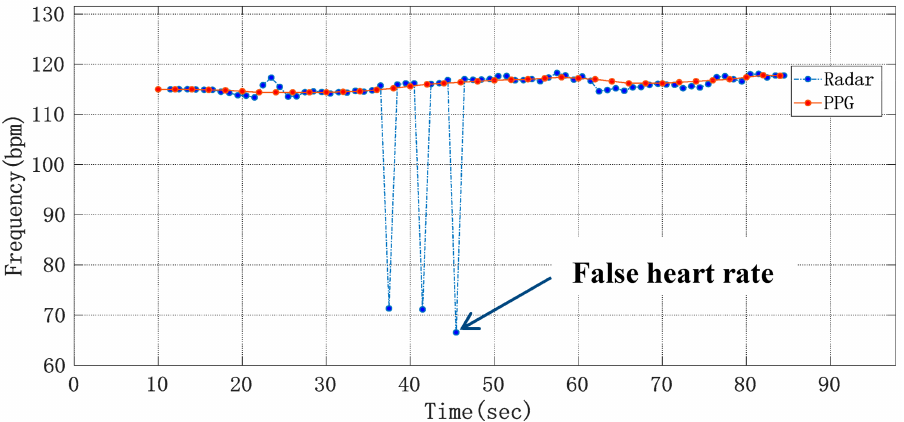
Figure 12. Curve of average heart rate changing with time.